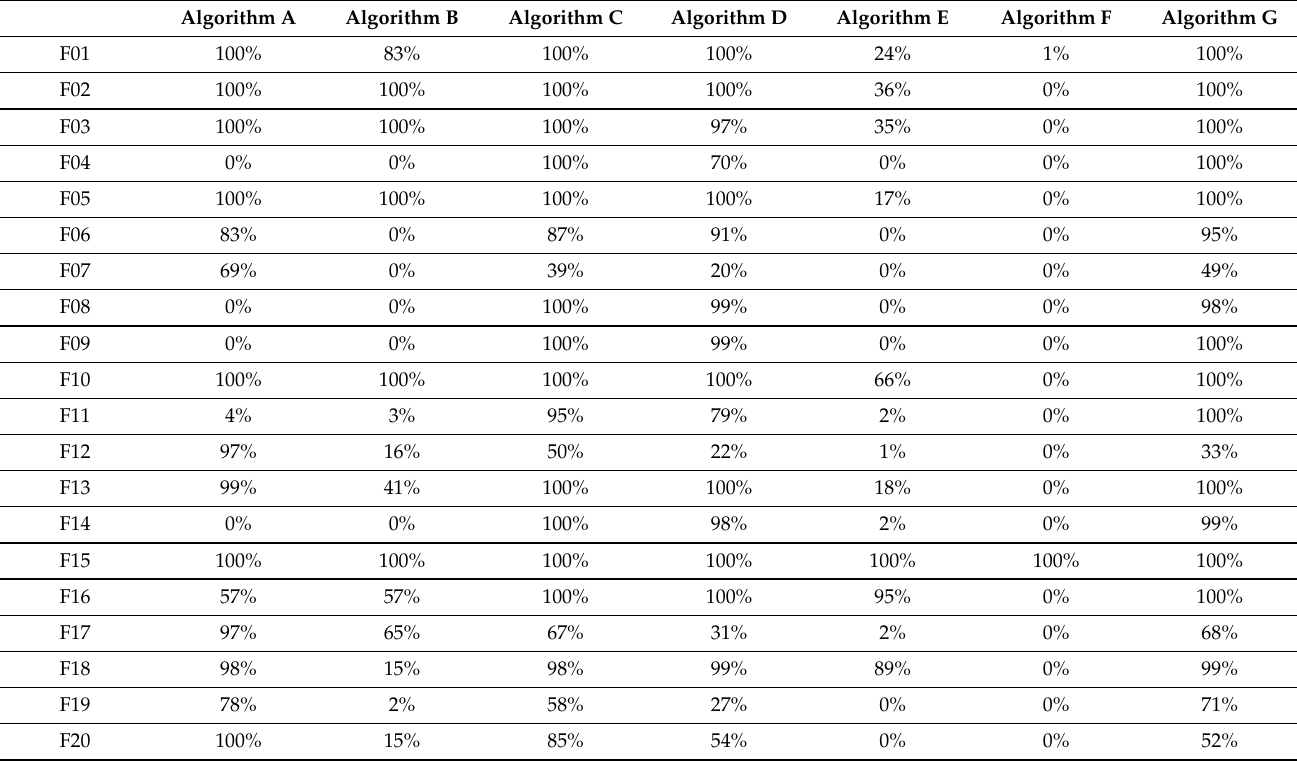
Table 5. Success rate (SR).